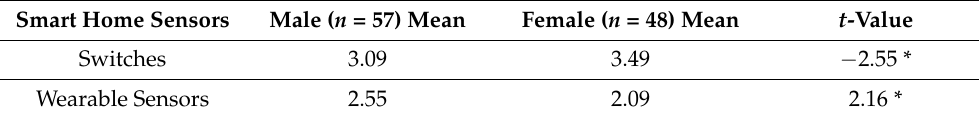
Table 8. Smart Home Sensors Preference by Gender.